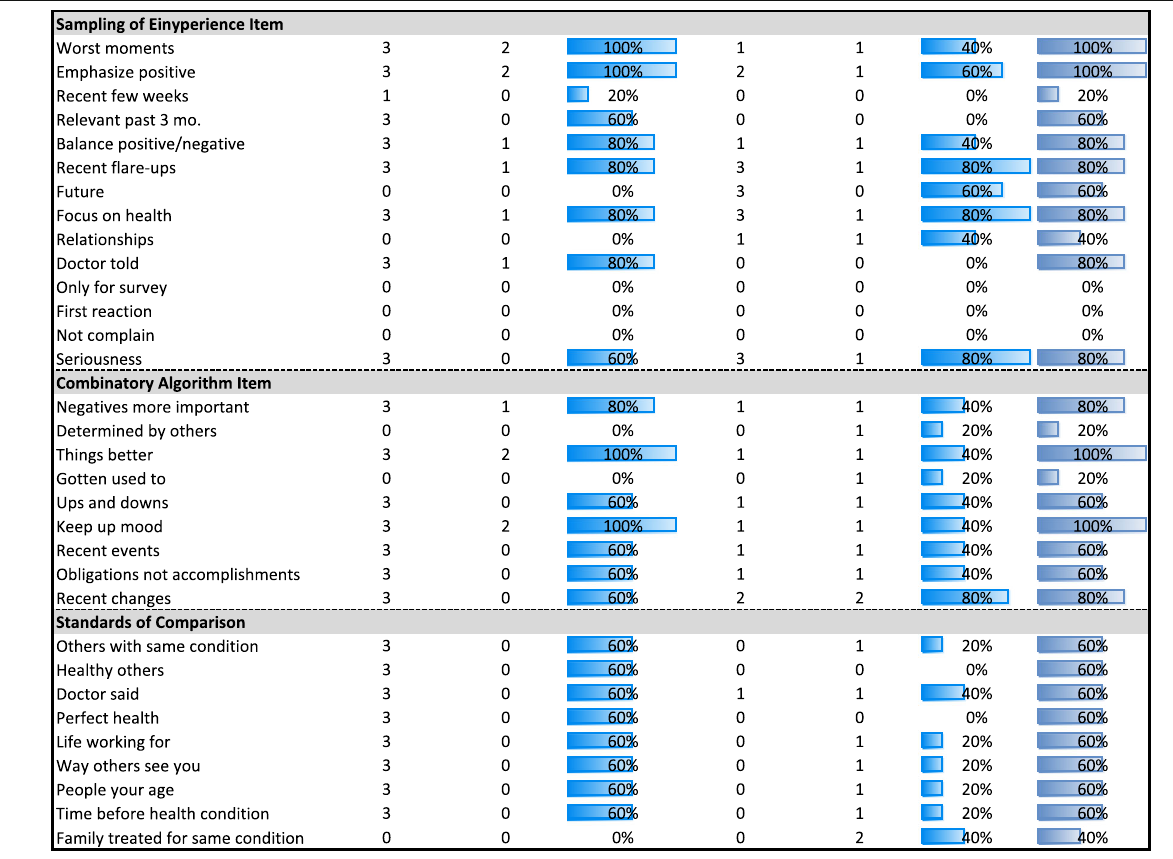
Table 7 Tallied Summary of Results